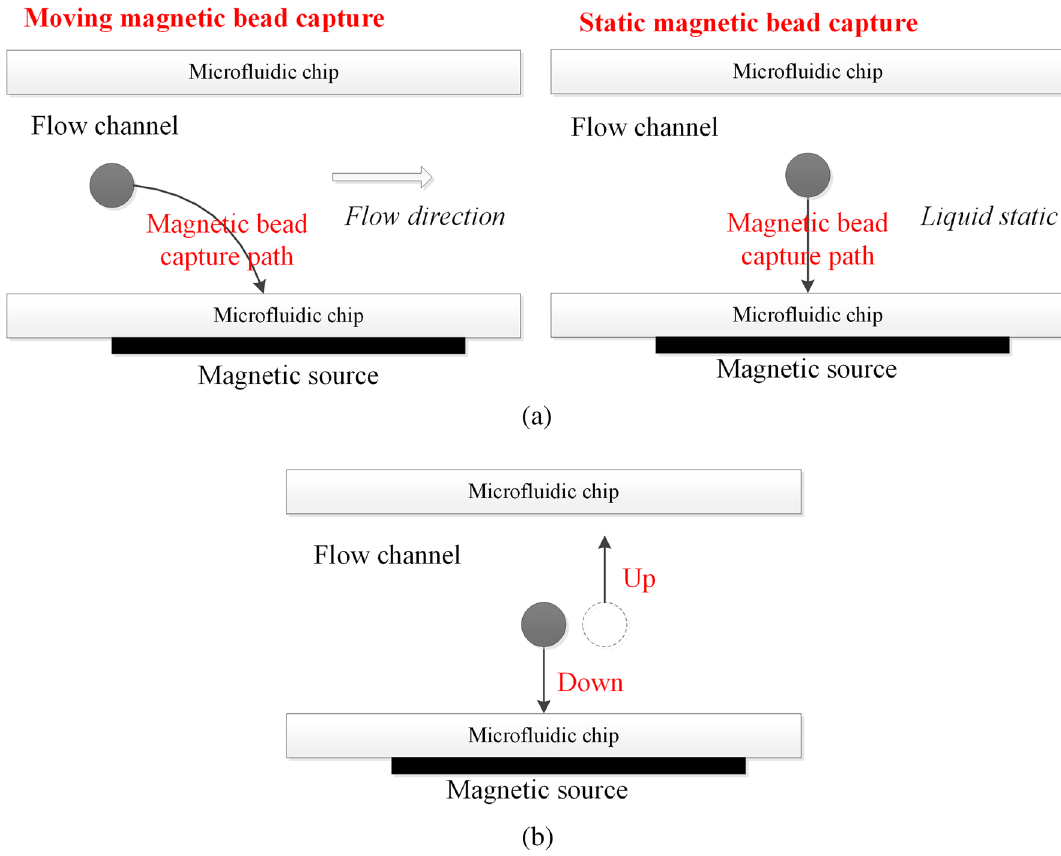
Figure 1. Magnetic bead control motion. ( a ) Magnetic bead capture. ( b ) Magnetic bead mixing with the